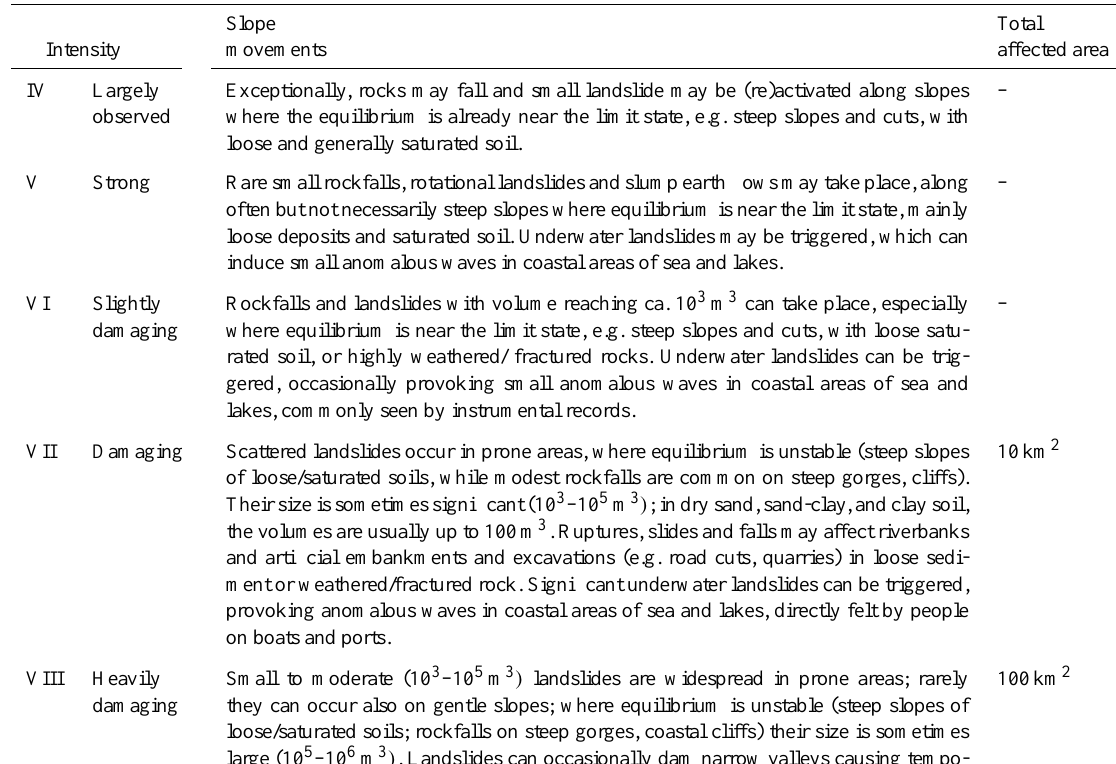
Table 1. Extraction from the ESI 2007 intensity degrees with description of secondary effects relevant for Krn Mountains 1998 earthquake (after Guerrieri and Vittori, 2007). Slope Total Intensity movements affected